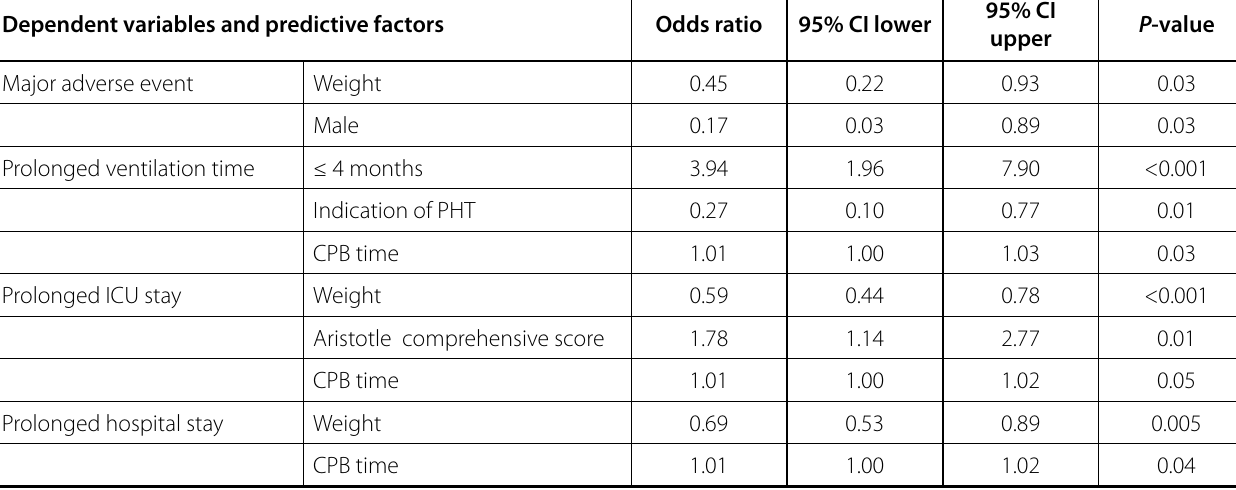
Table 4 . Multivariate analysis to determine independent predictive factors of major adverse events, postoperative ventilation, and intensive care unit (ICU) and hospital stay